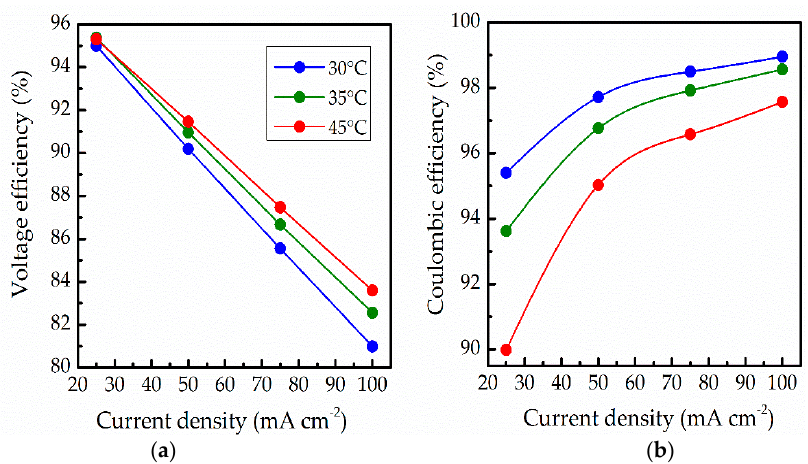
Figure 1. Voltage efficiency ( a ), coulombic efficiency ( b ) of VRFB single cells with 20 cm 2 active area at 30, 35 and 45 °C. Cycling was performed using a Fumasep ® FAP450 anion-exchange membrane and with a 1.6 M Vanadium electrolyte between state-of-charge (SOC) of 10% and 90%.